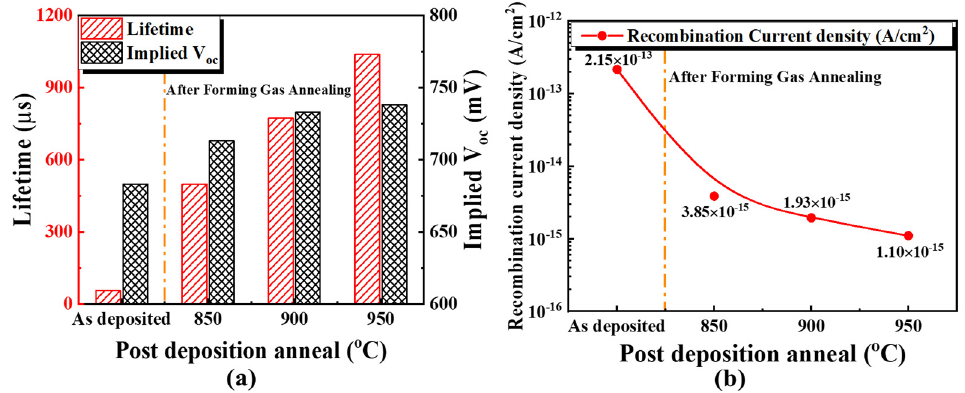
Figure 3. ( a ) Minority carrier lifetime and implied open-circuit voltage as functions of T PDA at 30 nm nc-SiO x layer thickness. ( b ) Recombination current density as a function of T PDA.